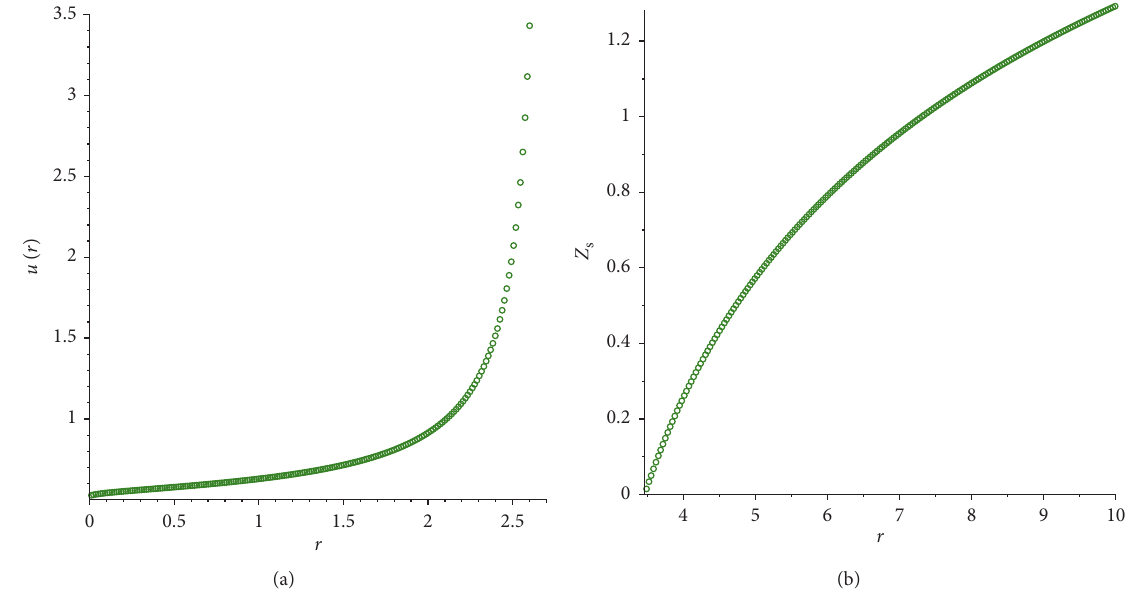
Figure 7: Plots of the compactness parameter and surface redshift with respect to the radial